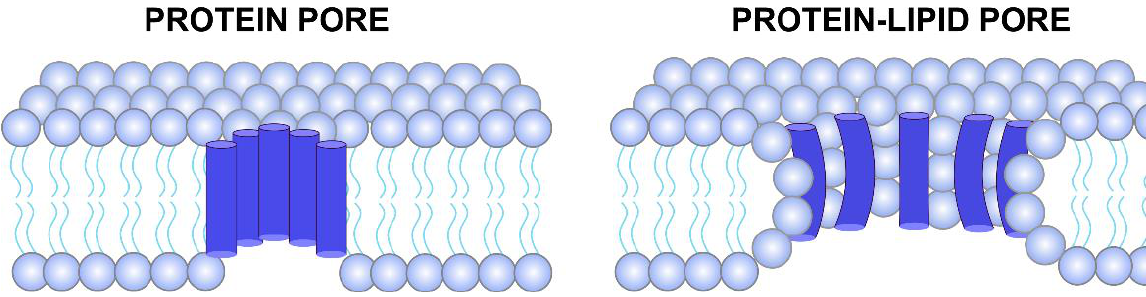
behaves quite differently when reconstituted in neutral or negatively-charged membranes (Figure 2).